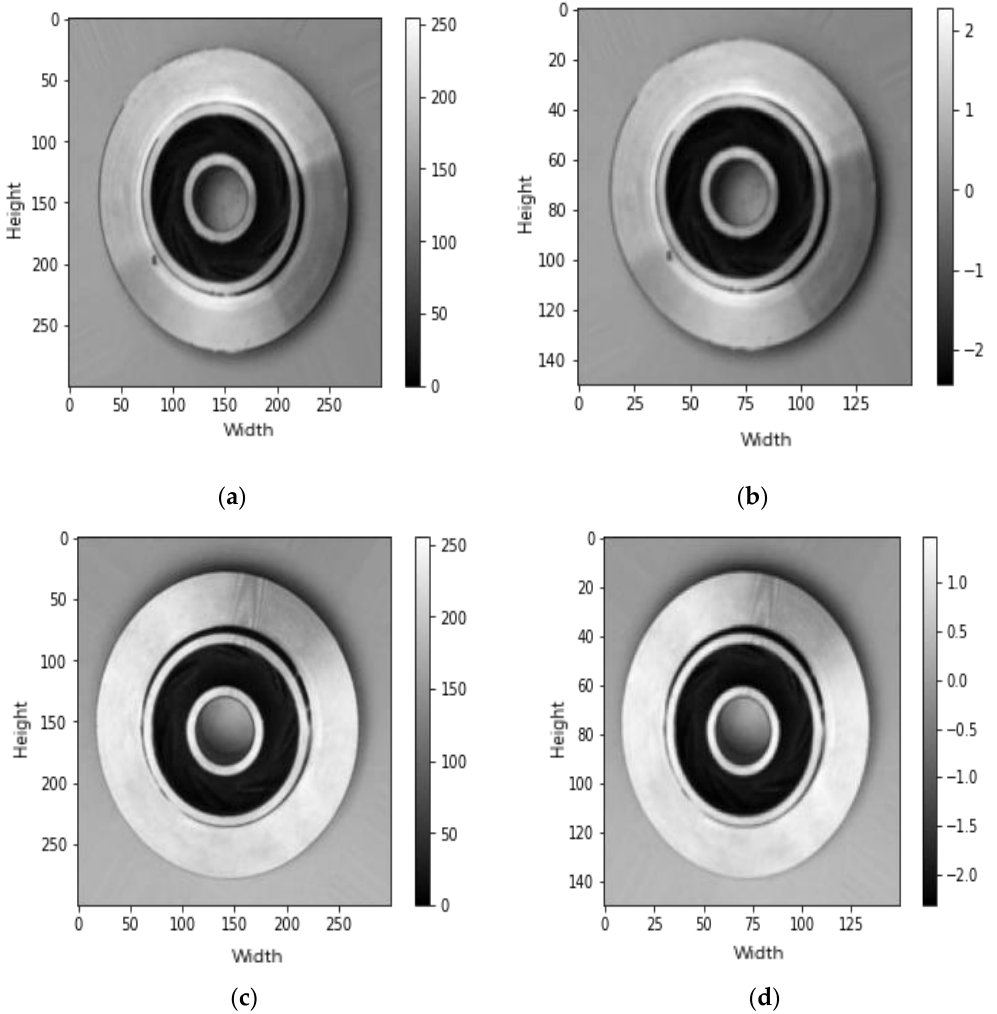
Figure 2. ( a ) def-front image before preprocessing; ( b ) def-front image after preprocessing; ( c ) ok-front image before preprocessing; ( d ) ok-front image after preprocessing.